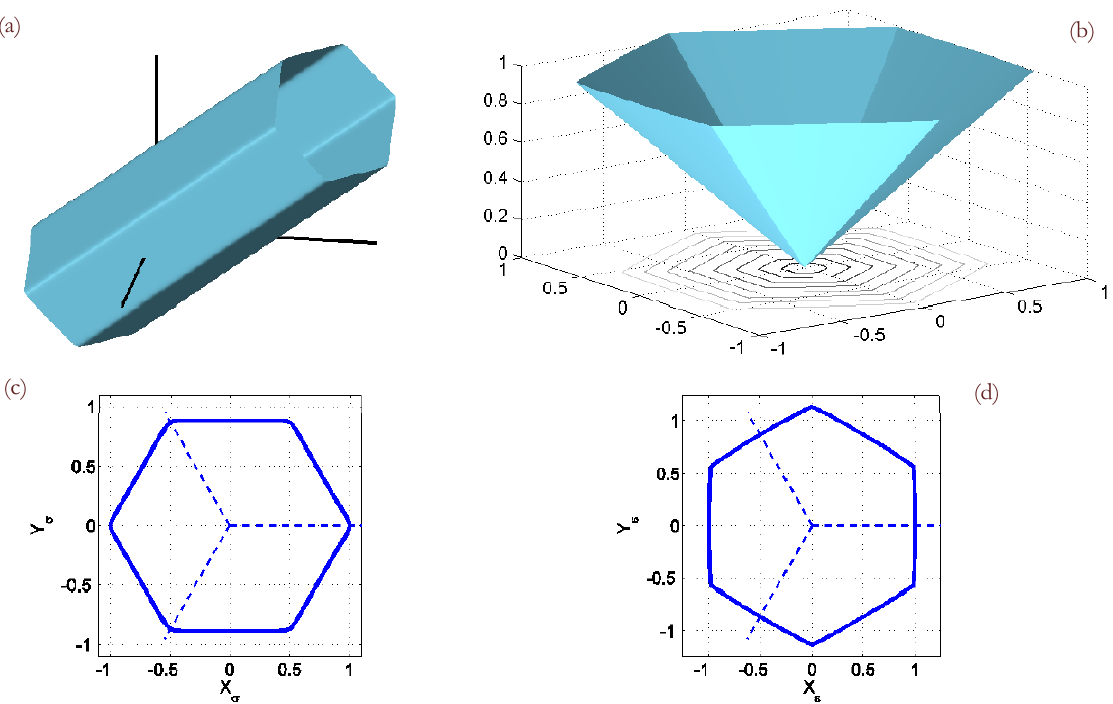
Figure 6: Von Mises–Tresca ( 20 m  ) yield function. (a) Yield surface; (b) Deviatoric section of the yield surface; (c) Dissipation function graph; (d) Unitary level set of the dissipation